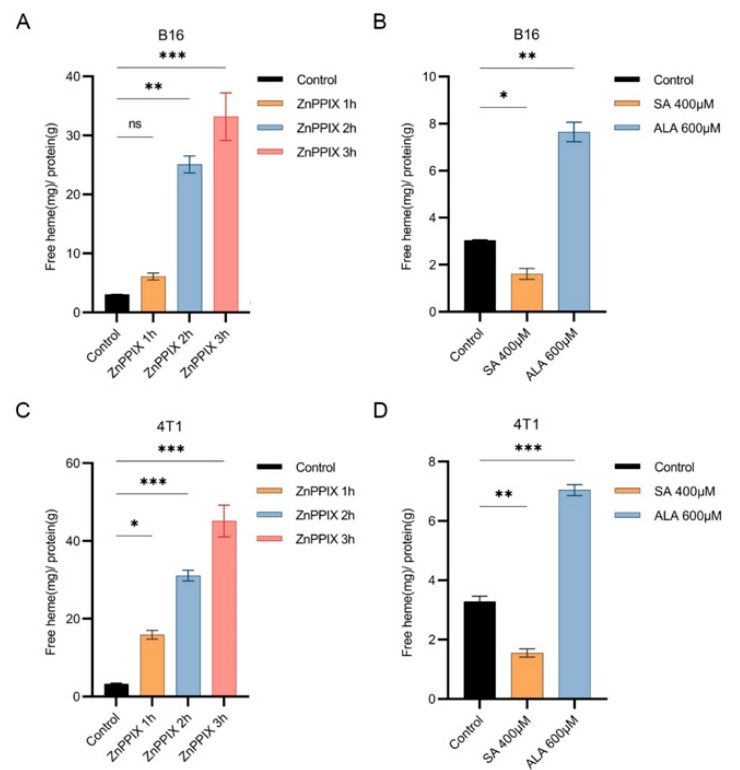
Figure 3. ZnPPIX elevates the labile heme concentration. ( A ) ZnPPIX increased labile heme levels in B16 cell. Two hours after treatment, a significant elevation of free heme was observed. ( B ) Altered heme levels in B16 cells after treated by SA and ALA, separately. ( C ) ZnPPIX obviously elevated labile heme levels in 4T1(C) cells 1 h after drug application. ( D ) Changed heme contents in 4T1(C) cells after SA and ALA treatments. * p < 0.05, ** p < 0.01, *** p < 0.001.